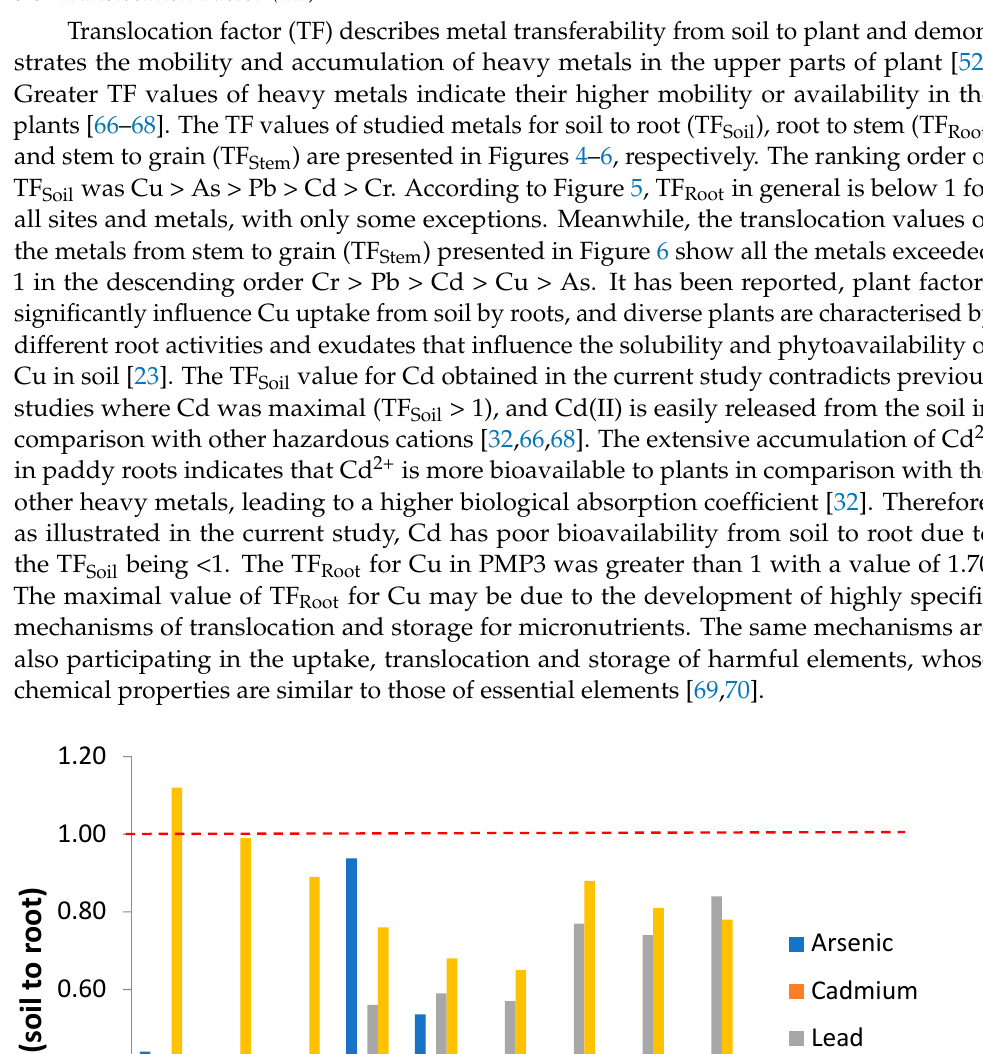
Figure 5. Translocation factor of the heavy metals from root to stem (TF Root ) at different sampling sites. KBP1: Kota Bharu Plot 1, KBP2: Kota Bharu Plot 2, KBP3: Kota Bharu Plot 3, PMP1: Pasir Mas Plot 1, PMP2: Pasir Mas Plot 2, PMP3: Pasir Mas Plot 3, PPP1: Pasir Puteh Plot 1, PPP2: Pasir Puteh Plot 2, and PPP3: Pasir Puteh Plot 3.